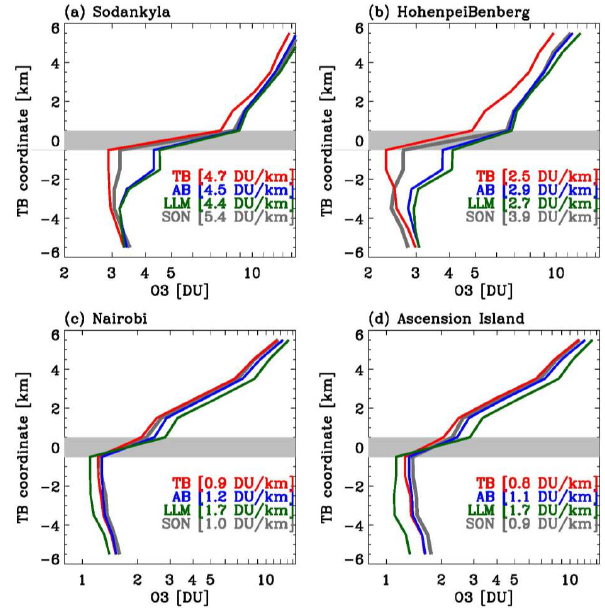
Fig. 12. Same as Fig. 11, but for a priori profiles used in OMI Figure 12. Same as Figure 11, but for a priori profiles used in OMI retrievals. 2 Table 1. List of Ozonesonde Stations 4 Station